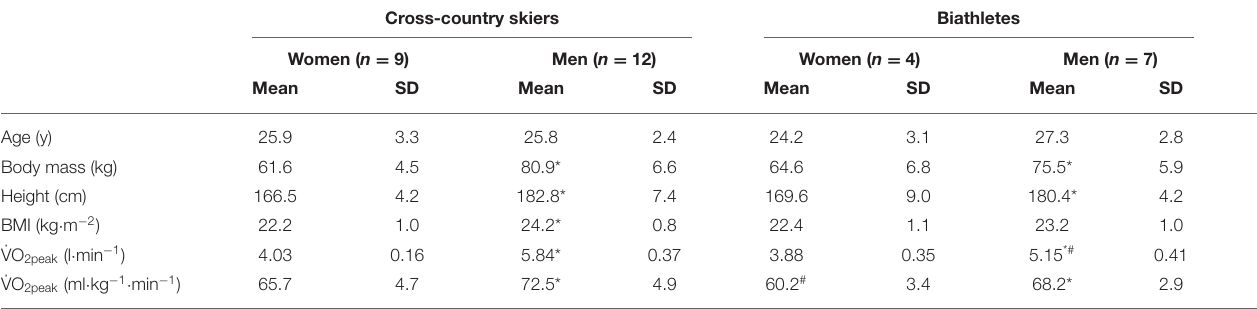
TABLE 1 | Mean and standard deviation (SD) descriptive characteristics of the participating cross-country skiers and biathletes. Cross-country skiers